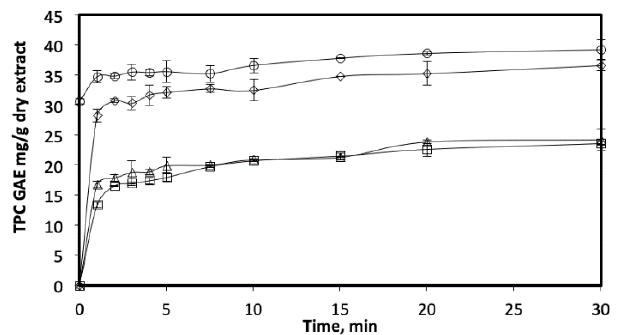
Figure 2. Total phenolic content (TPC) monitorization at different time points using different extraction processes: conventional ( □ ), SFI ( Δ ), SAI ( ) and PSAI ( ο ).